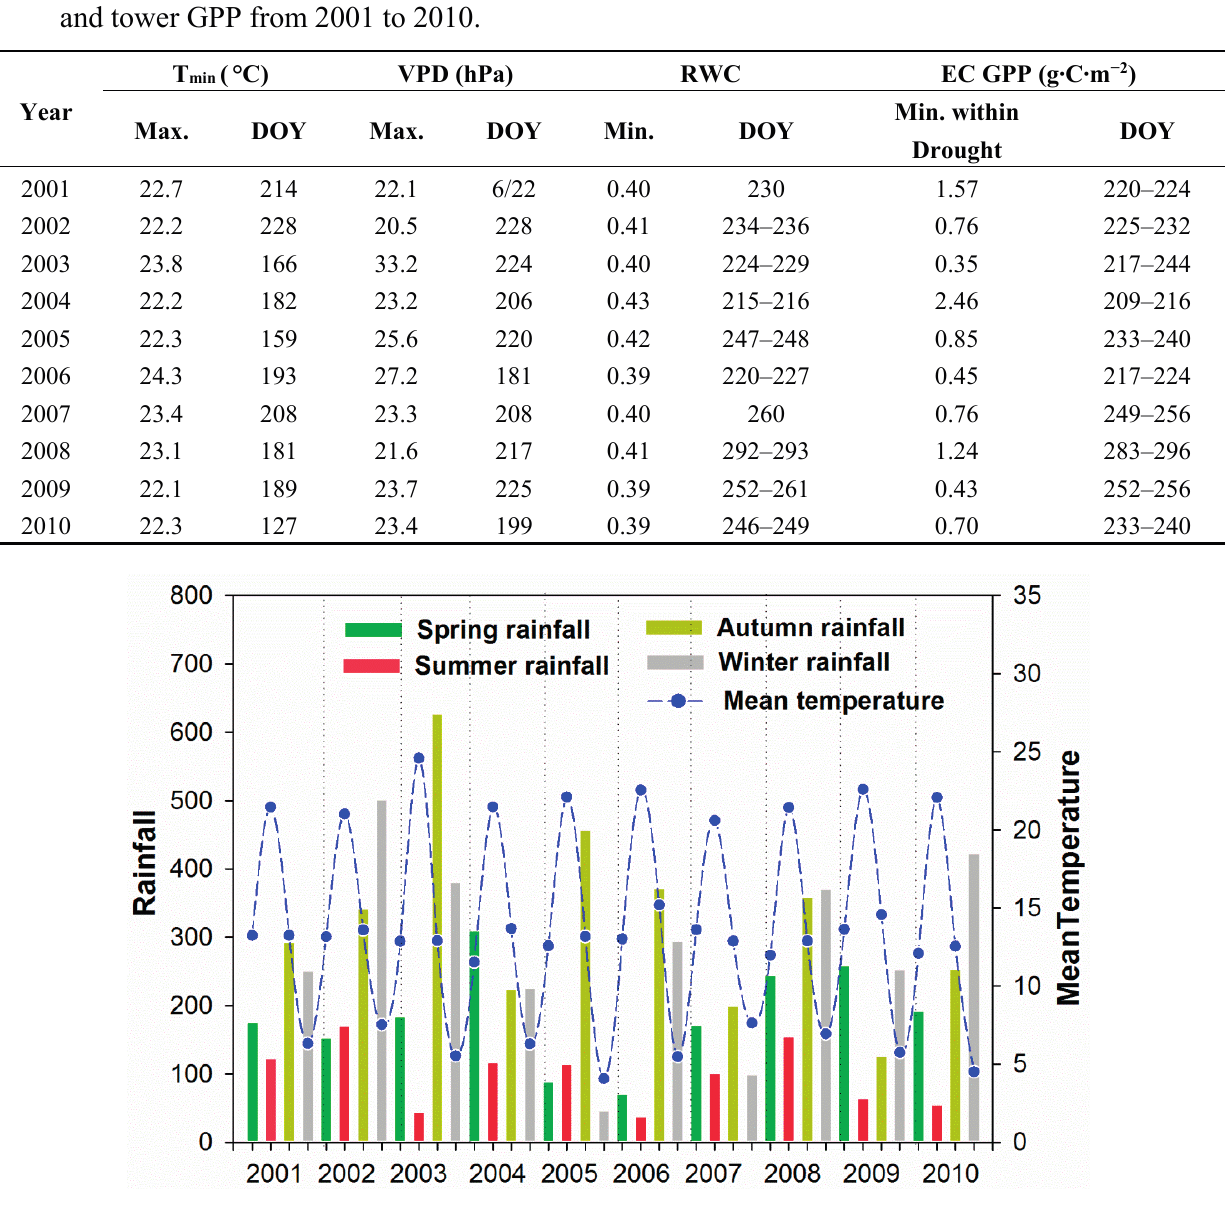
Figure A1. Meteorological data collected about average temperature (° C) and accumulated seasonal precipitation (mm) at the flux tower site from 2001–2010. The dashed lines are the dividing lines of